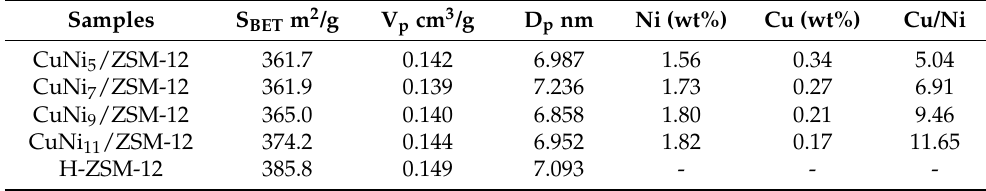
Figure 3. N 2 -adsorption/desorption curves ( a ) and pore size distributions ( b ) of H-ZSM-12 and CuNi x /ZSM-12 catalysts. Table 1. Structural information and metal loadings of prepared